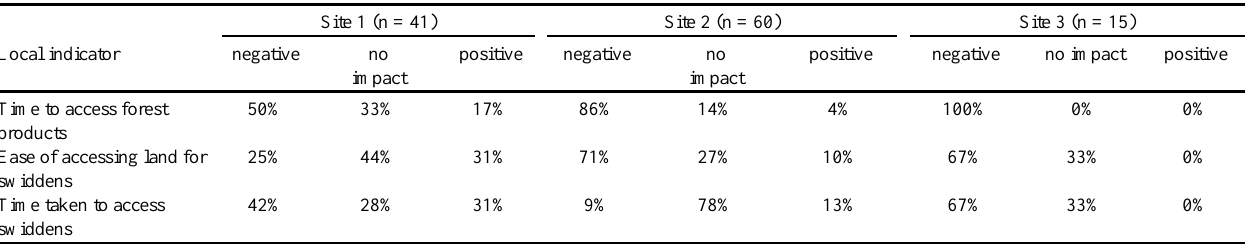
Table 9 . Perceived livelihood impacts of oil palm plantations according to former landowners and customary users. Site 1 (n = 41) Site 2 (n = 60) Site 3 (n = 15) Local indicator negative no positive negative no positive negative no impact positive impact impact 50% 33%